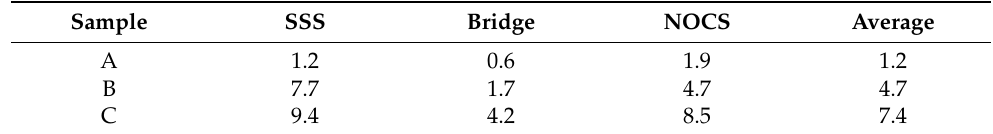
Table 3. Average calculated section loss ( µ m).